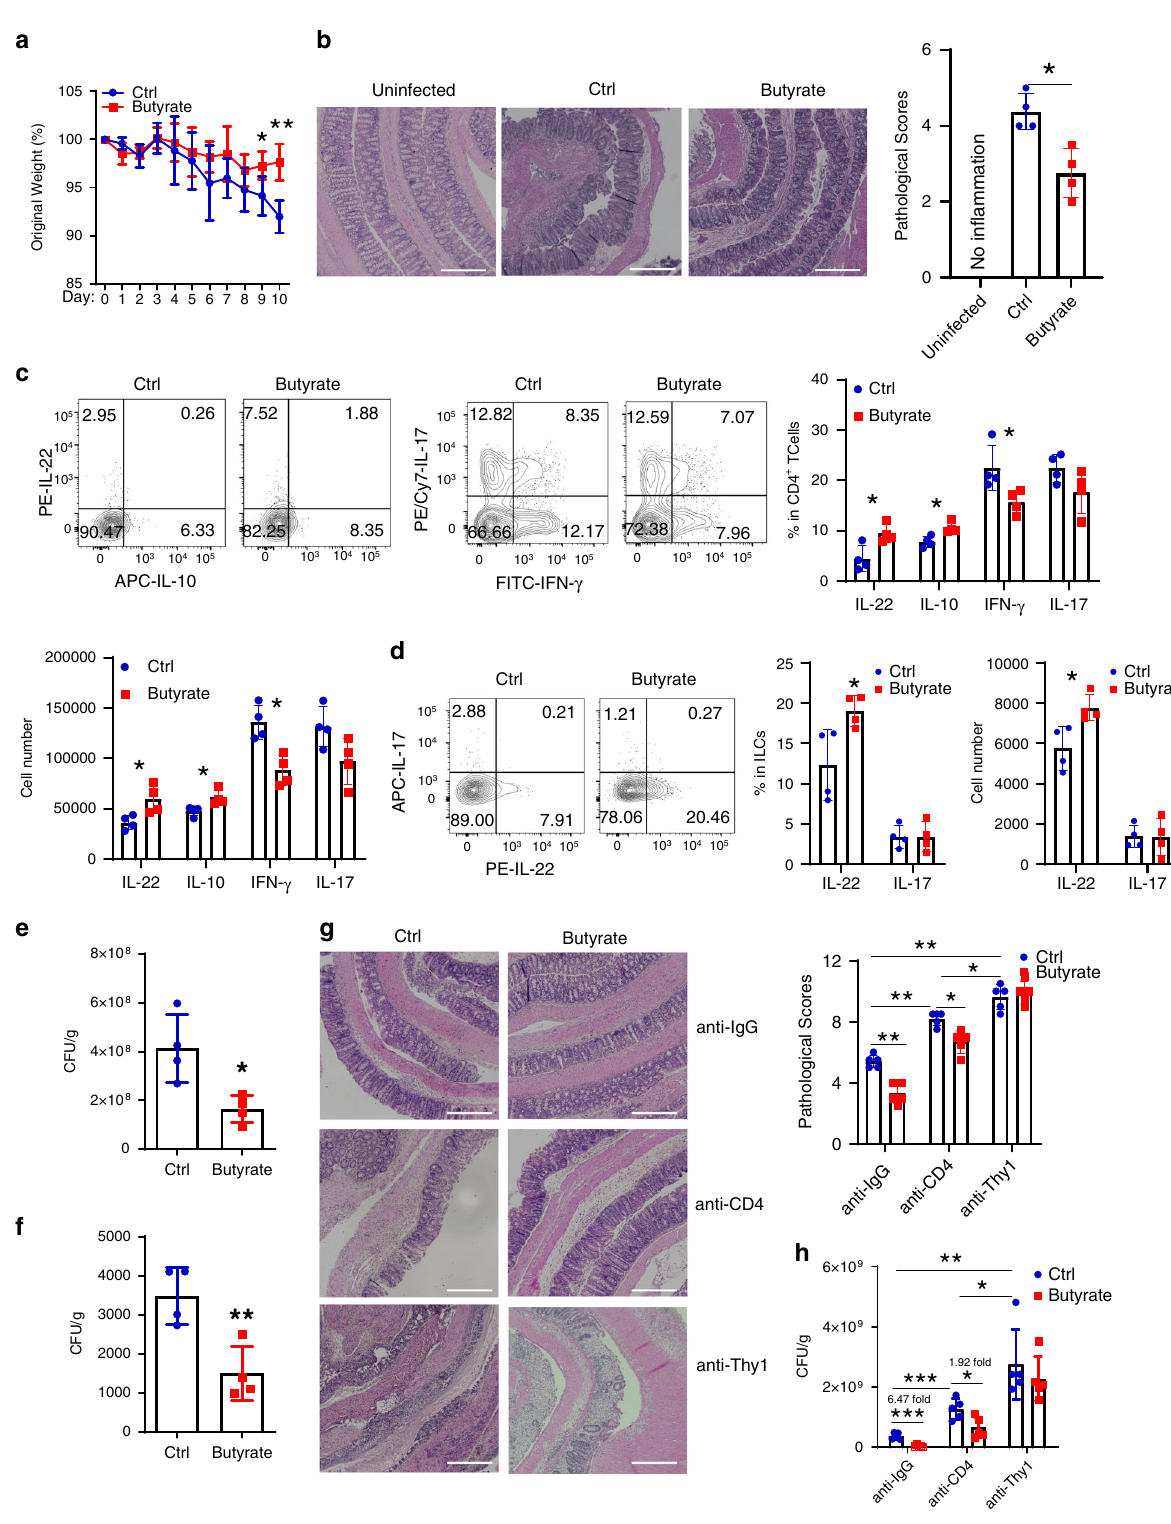
Butyrate promotes human CD4 + T cell IL-22 production . To assess whether butyrate induces CD4 + T cell IL-22 production in IBD patients for translational potential, we treated peripheral blood CD4 + T cells, isolated from healthy volunteers, and patients with active Crohn ’ s disease (CD) and ulcerative colitis (UC), with anti-CD3 mAb and anti-CD28 mAb with or without butyrate. Butyrate promoted Il22 mRNA levels in human CD4 +